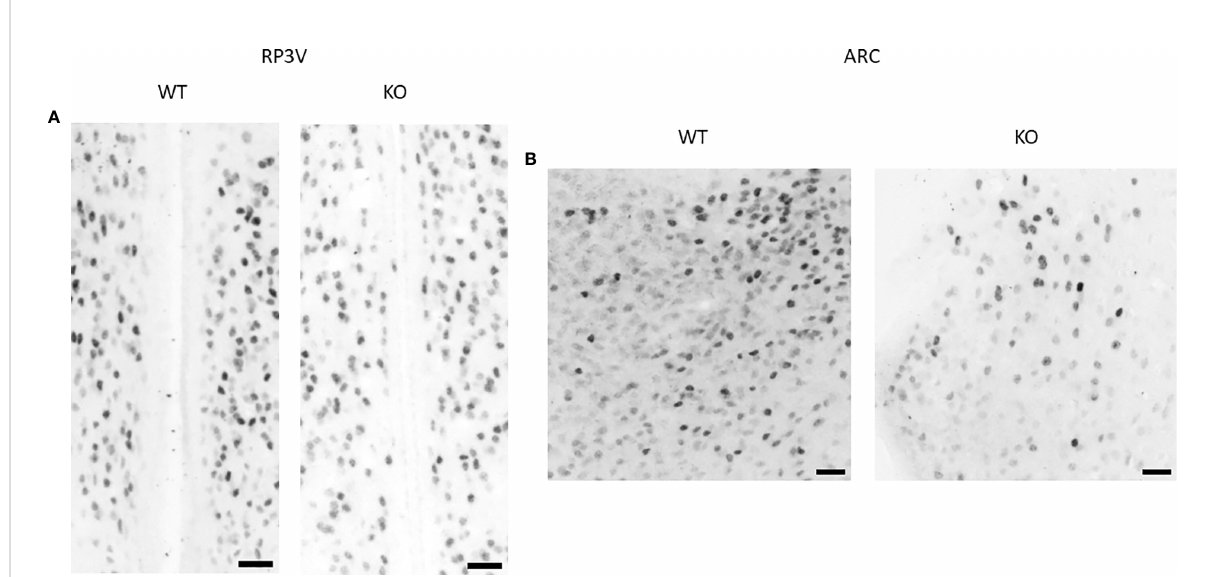
FIGURE 8 ER a protein expression in the RP3V and ARC in wild-type and PACAP KO female mice. Representative bright fi eld images show the expression of ER a protein in the RP3V (A) and ARC (B) of a WT and a PACAP KO female mouse. 20× magni fi cation, scale bar: 25